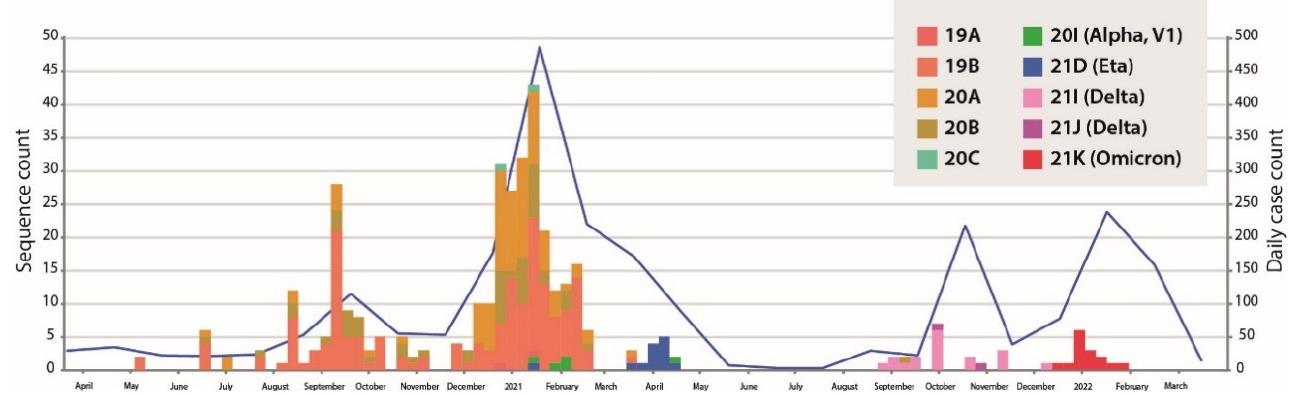
Figure 1. COVID-19 confirmed cases and SARS-CoV-2 genetic diversity in western Burkina Faso. Timeline showing the collection dates of the confirmed COVID-19 cases in western Burkina Faso from 9 March 2020 to 20 March 2022 and the during this period (blue line). The colors of bars represent the clades (NextClade nomenclature) that were identified and the heights of bars correspond to the number of sequenced samples each week and passing the global initiative on sharing avian influenza data (GISAID) quality control.